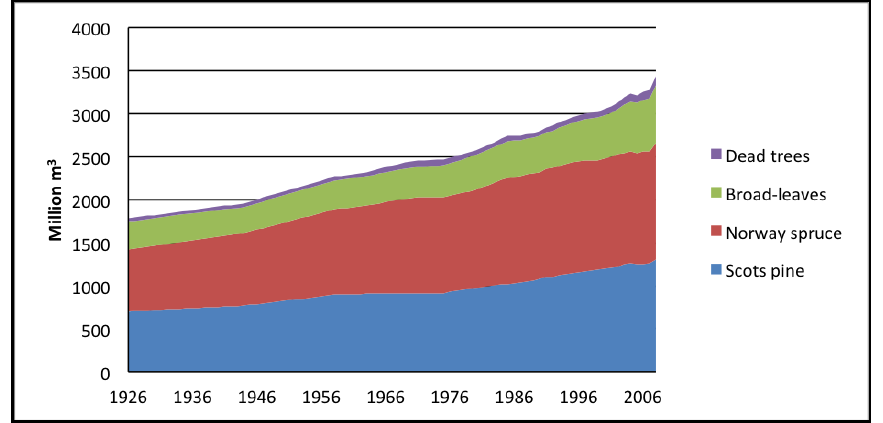
Figure 8. Total standing stock (stem volume) in Swedish forests 1926–2008